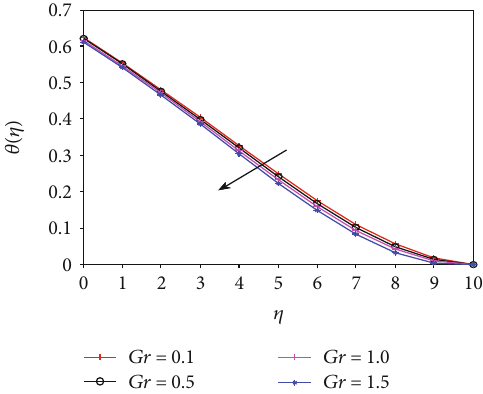
Figure 7: Temperature pro fi les for sundry values of Gr once Pr = 0 : 72 , λ = M = Ra = Bi = 0 : 1